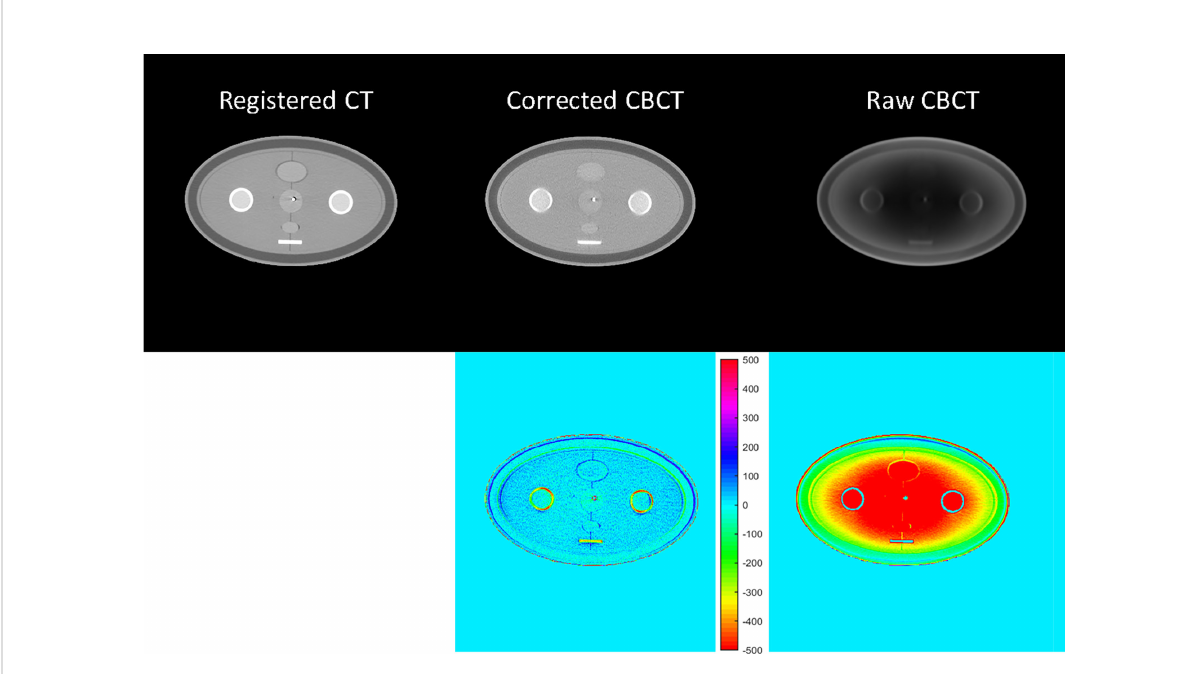
FIGURE 4 CT/CBCT images of the female pelvis phantom in the axial view and the CT number difference map of CBCT and CT; display window: [ − 500 500] HU.